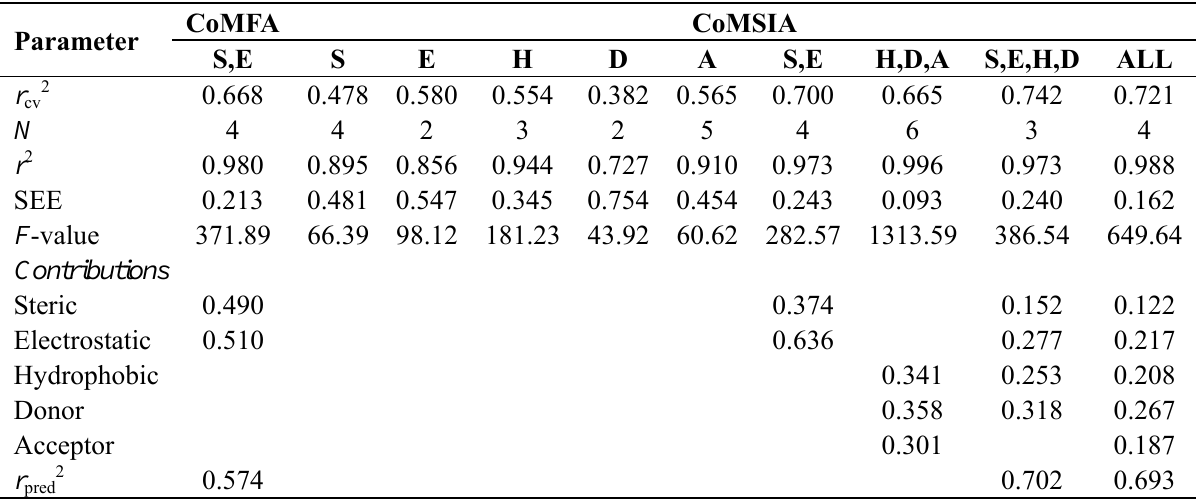
Table 2. Results of CoMFA and CoMSIA analyses with pharmacophore-based alignments. Parameter